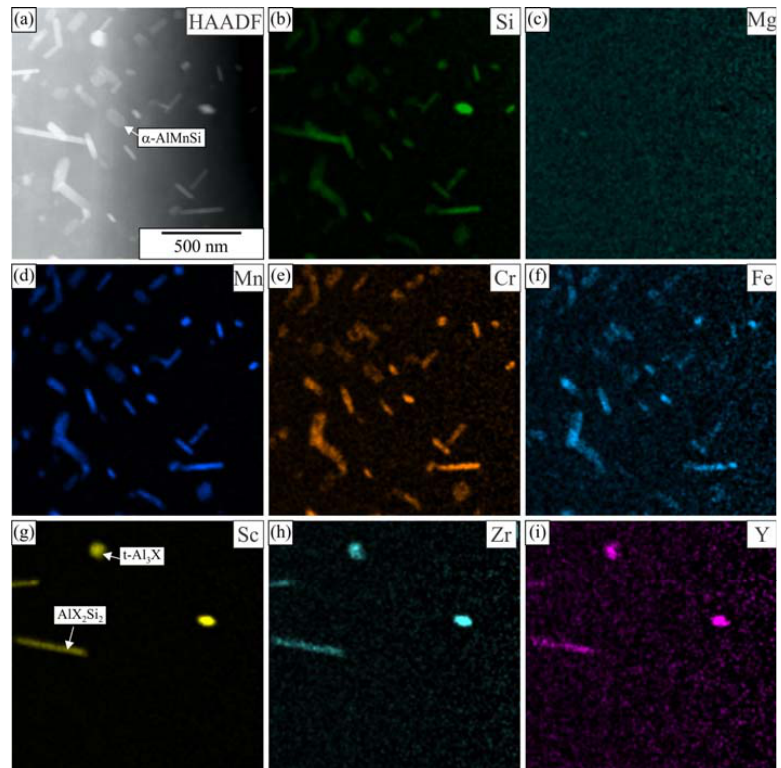
Figure 8. Distribution of the elements within the matrix of the alloy 6086-ScY after homogenization ( a ) HAADF micrograph, EDS mapping of selected elements, ( b ) Si, ( c ) Mg, ( d ) Mn, ( e ) Cr, ( f ) Fe, ( g ) Sc, ( h ) Zr, and ( i ) Y.